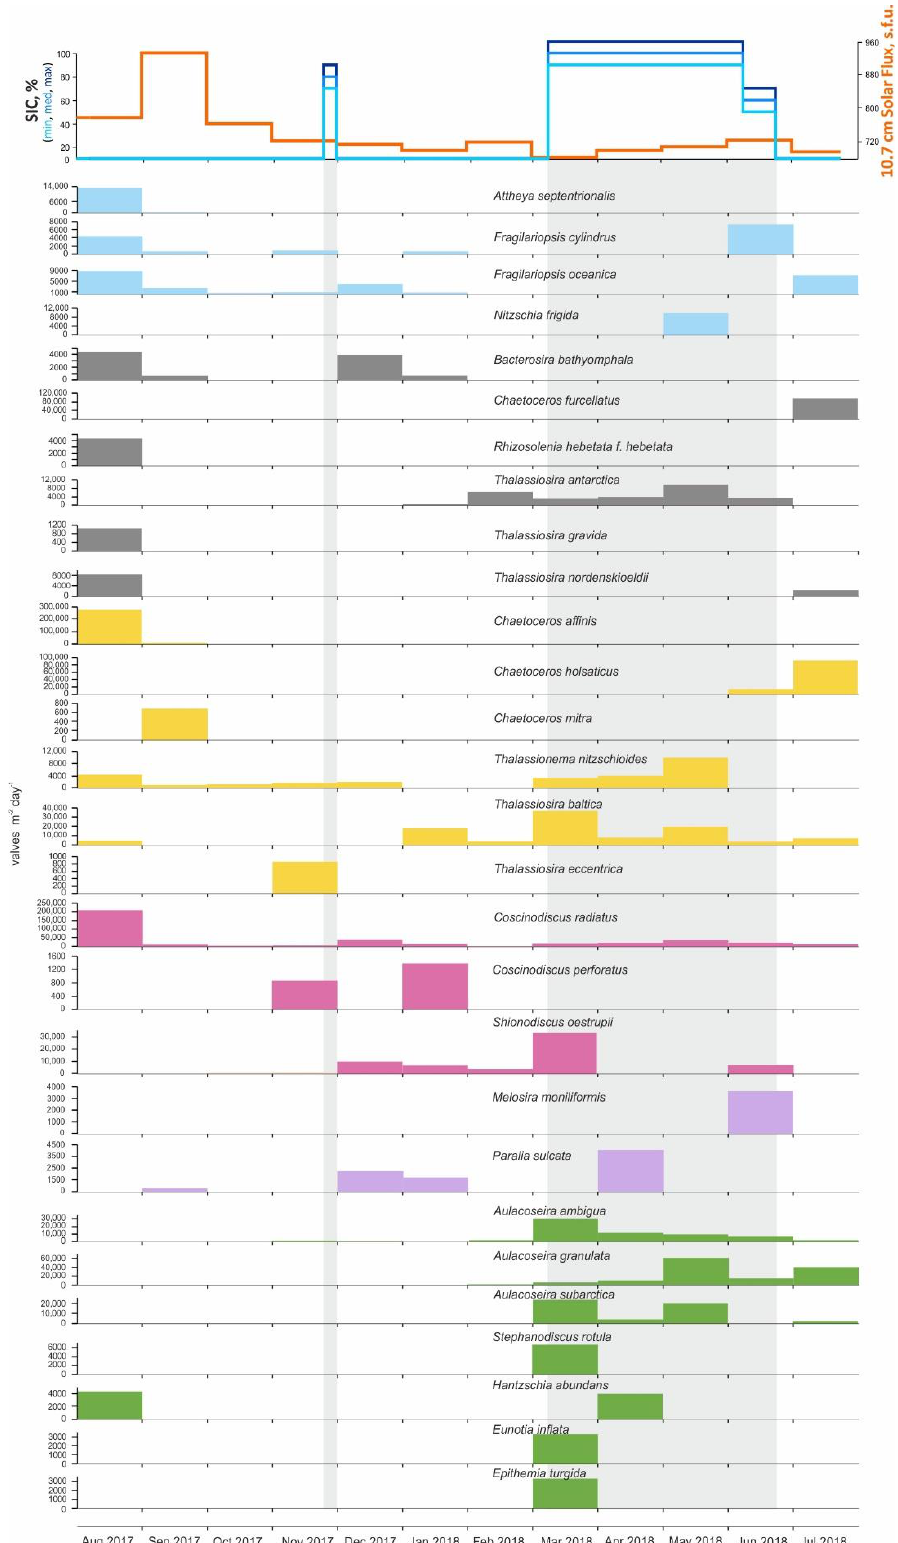
Figure 6. Annual diatom fluxes in the East Barents Sea Depression. Legend: sea-ice diatom species— blue, ice-neritic species—grey, neritic species—yellow, Atlantic species—magenta, sublittoral species— purple, freshwater species—green. The top shows the sea-ice cover (concentration in %), and solar flux, light gray rectangles mark the ice-covered season (SIC >